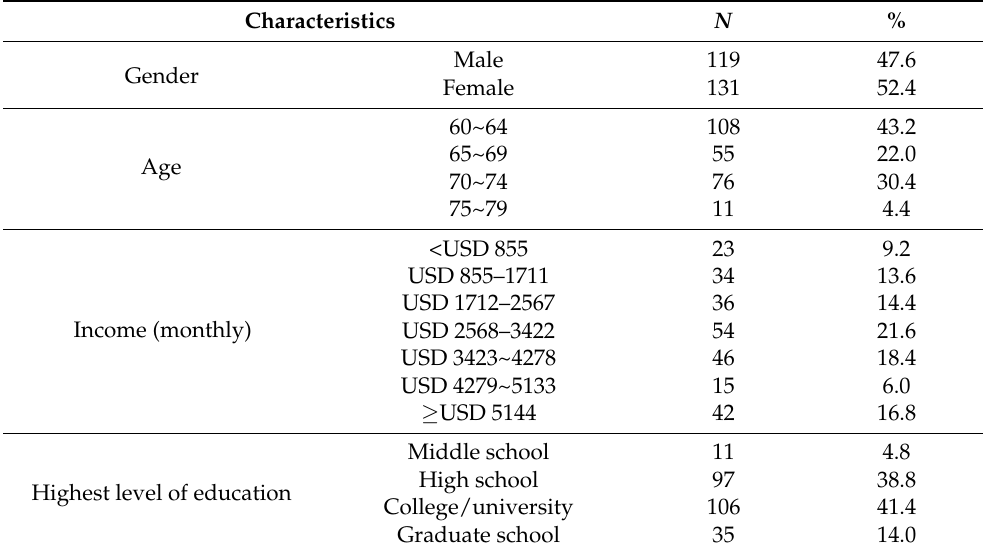
Table 1. Demographic characteristics of